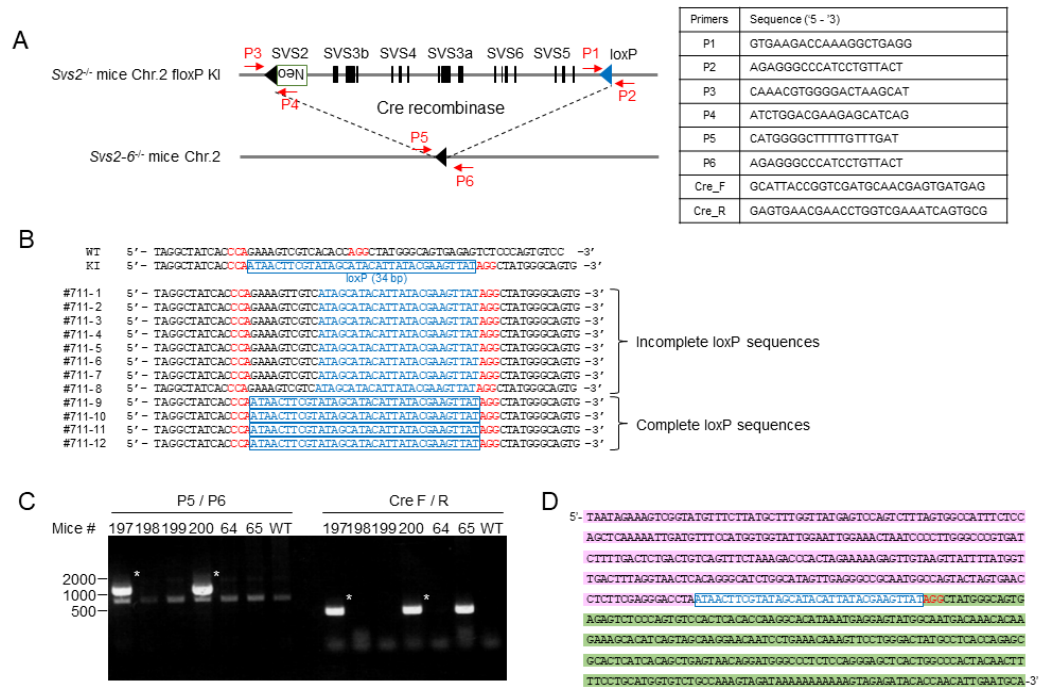
Figure 4. Validation of the Svs2 − / − allele carrying a loxP-insertion using sequencing, PCR, and cre-recombination. ( A ) Primer sequences used in this study. ( B ) Sequence analysis of founder mouse (F0, #711). Genomic DNA of the #711 mouse was amplified by PCR (P1 / P2) to detect loxP-insertion at the targeted locus. Genetic chimerism was observed in the #711 mouse; both complete and incomplete loxP sequences were detected in the mouse. ( C ) PCR analysis of F2 pups (#197–200, 64, 65) derived from crosses with F1 mice and Meox-cre Tg mice with primer sets P5 / P6 as indicated in ( A ). PCR bands from Svs2–6 + − - mice marked with asterisks display 1000 bp and are cre-positive. ( D ) Sequences of PCR products with using P5 / P6 in an F2 mouse. Blue characters indicated loxP sequences, and red means PAM sequence. Pink and green shading characters indicate 5’ upstream of Svs2 and 3’ downstream of Svs5 , respectively.